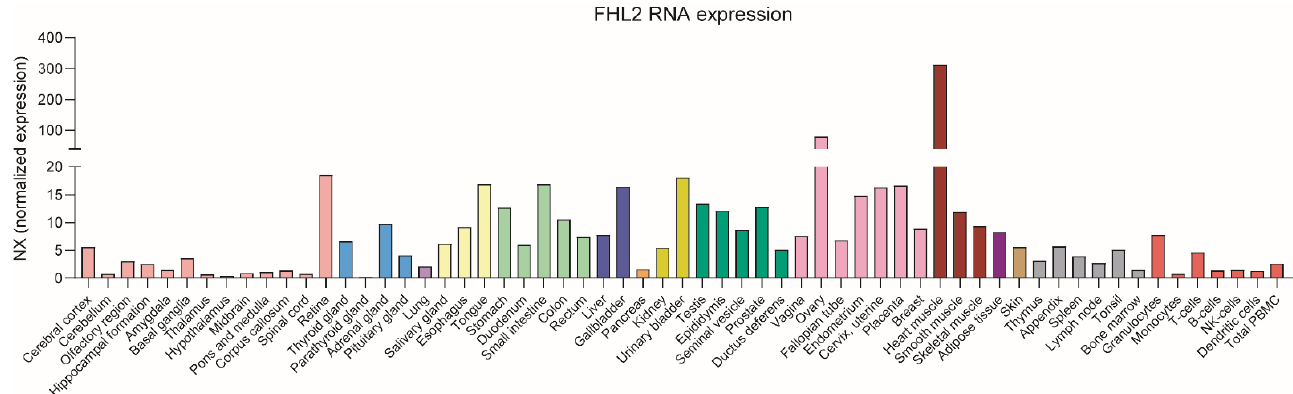
Figure 2. Normalized FHL2 mRNA expression in multiple tissues. Based on transcriptomic data from three sources: HPA, GTEx, and FANTOM5 (Protein Atlas: https://www.proteinatlas.org/). Accessed in July 2021.